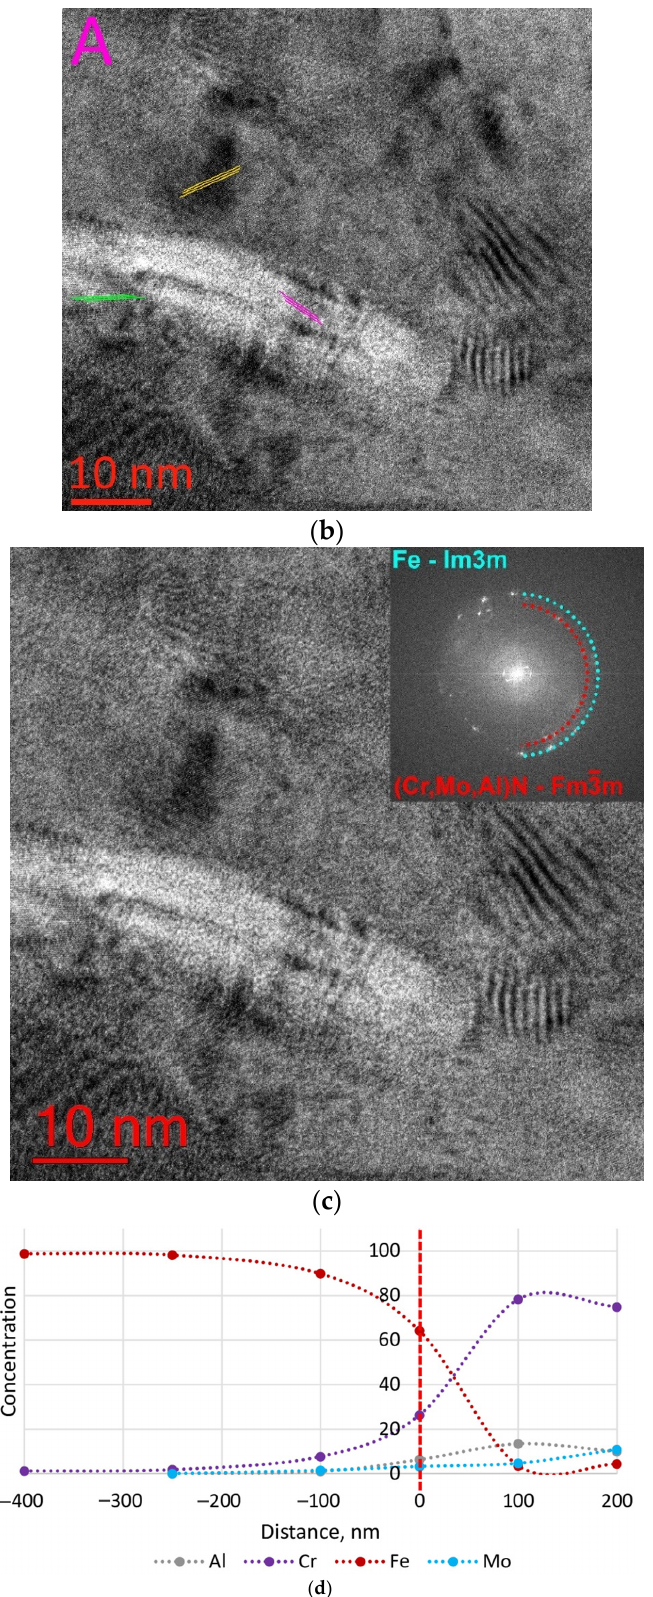
Figure 6. ( a , b ) Penetration of a fragment of the machined steel into the structure of the coating, ( c ) Fourier analysis of the area of the “coating-machined steel” interface, ( d ) study of the diffusion processes on the area of the “coating-machined steel” interface (line L1).